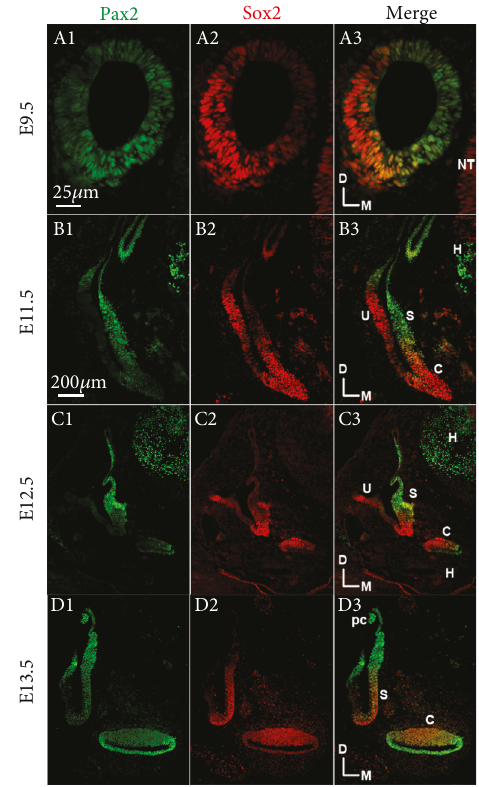
Figure 1: Comparison of Pax2, Sox2 expression in the inner ear from E9.5 to E13.5. Immuno fl uorescence staining of Sox2 (red), Pax2 (green), and Prox1 (green) in the mouse inner ear at E9.5, E11.5, E12.5, and E13.5. S: saccule; U: utricle; C: cochlea; D: dorsal; M: medial; pc: posterior crista; H: hindbrain; NT: neural tube. Scale bars=25 μ m (A1 – A3); 200 μ m (B1 – B3, C1 – C3,